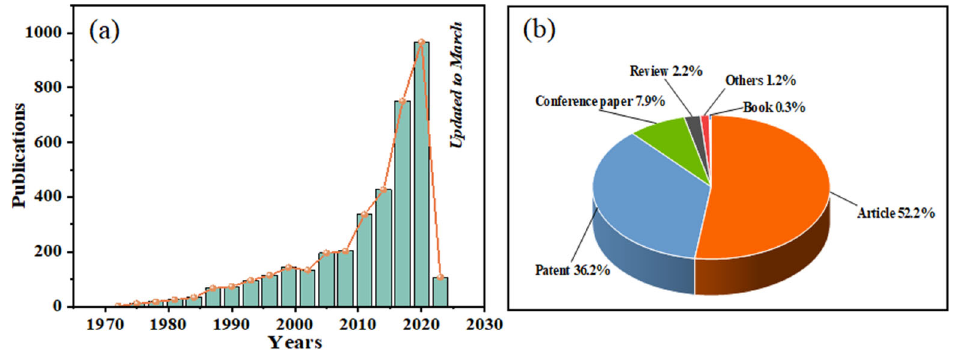
Figure 1. ( a ) Publication trend of the CFRC literature; ( b ) Types of documents in the CFRC literature.